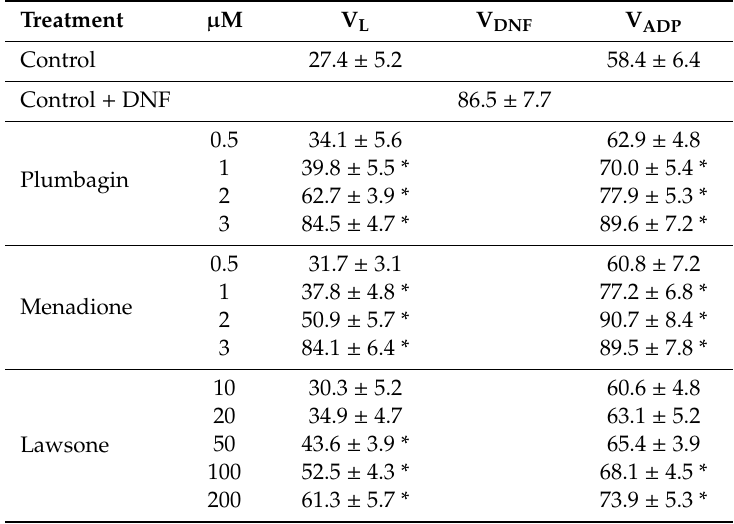
Table 1. E ff ect of 1,4-naphthoquinones on oxygen consumption in